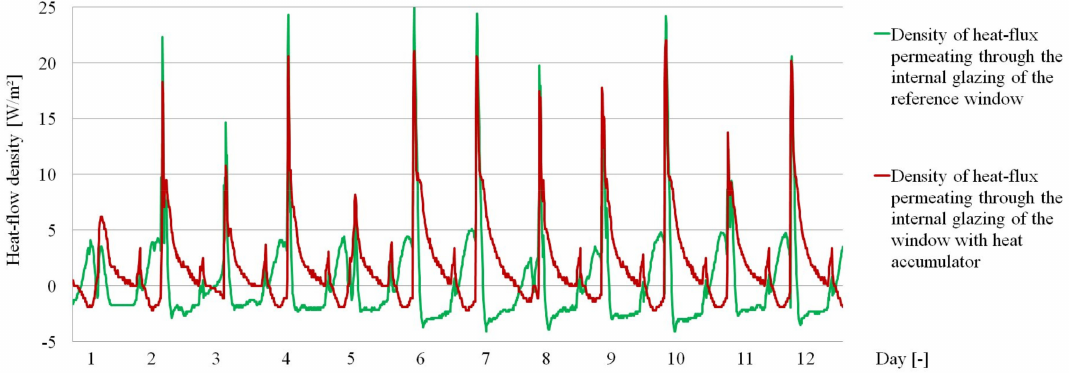
Figure 8. Values of the heat flux density recorded on the internal glazing of the window with the heat accumulator and the reference